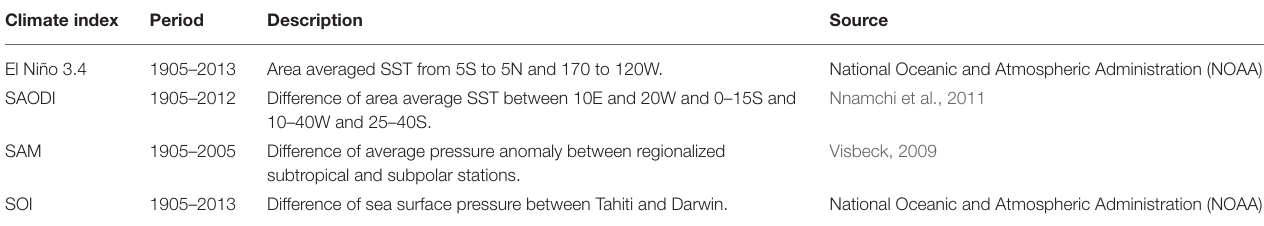
TABLE 1 | Description, period, and source of the Climate Indices. Climate